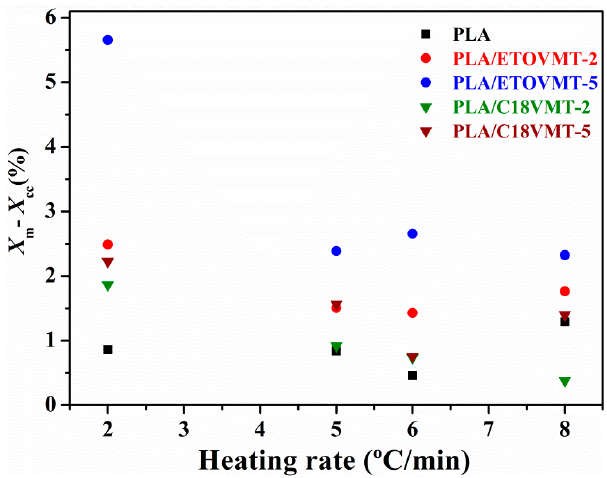
Figure 5. Crystallinity of PLA and PLA/VMT nanocomposites as a function of the heating rate.